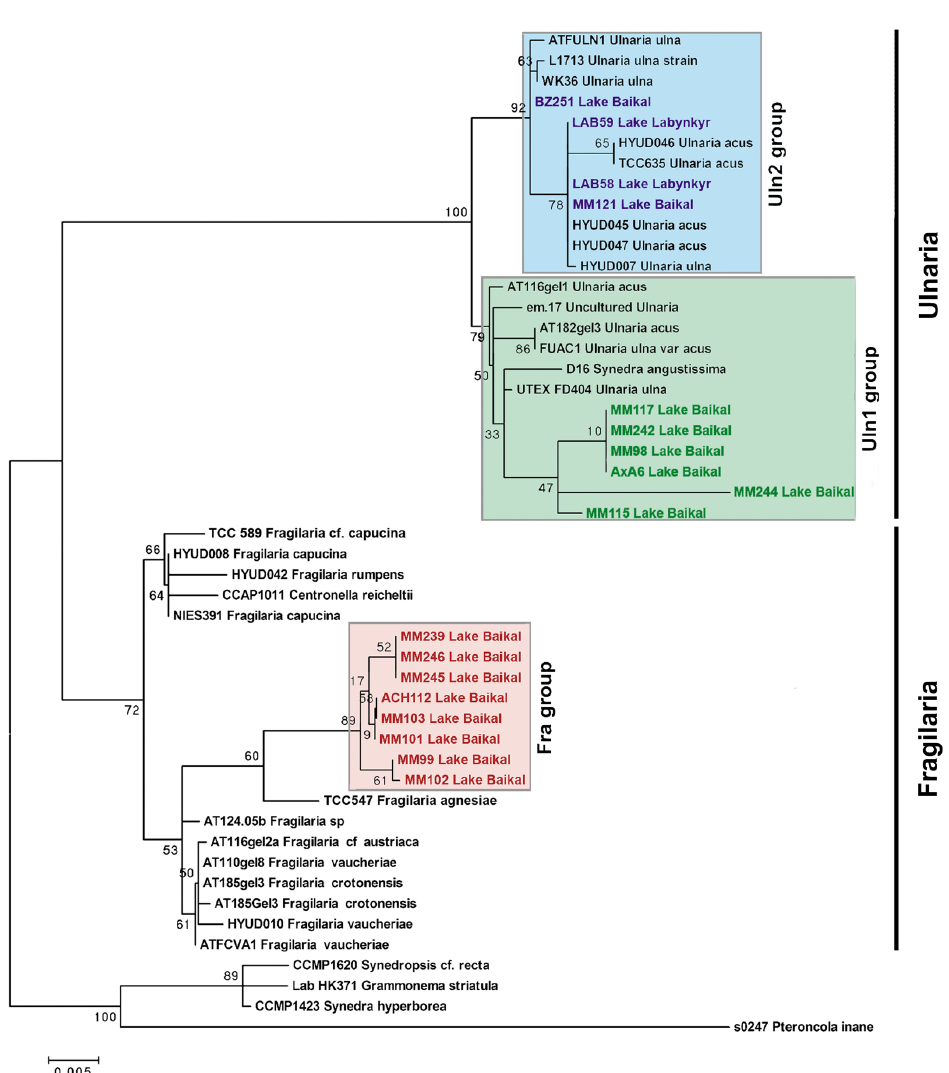
Figure 2. Maximum likelihood phylogenetic tree reconstructed based on 18S rRNA genetic marker (IQ-TREE program). The nodes for the key clusters specify ultrafast bootstrap topology support. The sequences obtained in this study were included in three different groups, Fra, Uln1 and Uln2, and highlighted in red, green and blue, respectively .